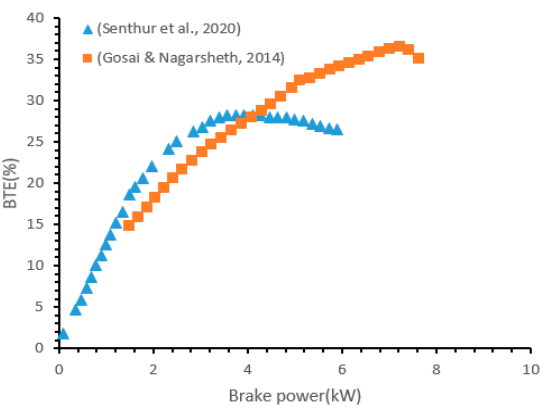
Figure 20. Brake thermal efficiency vs. brake power for different fuels in the LHR engines